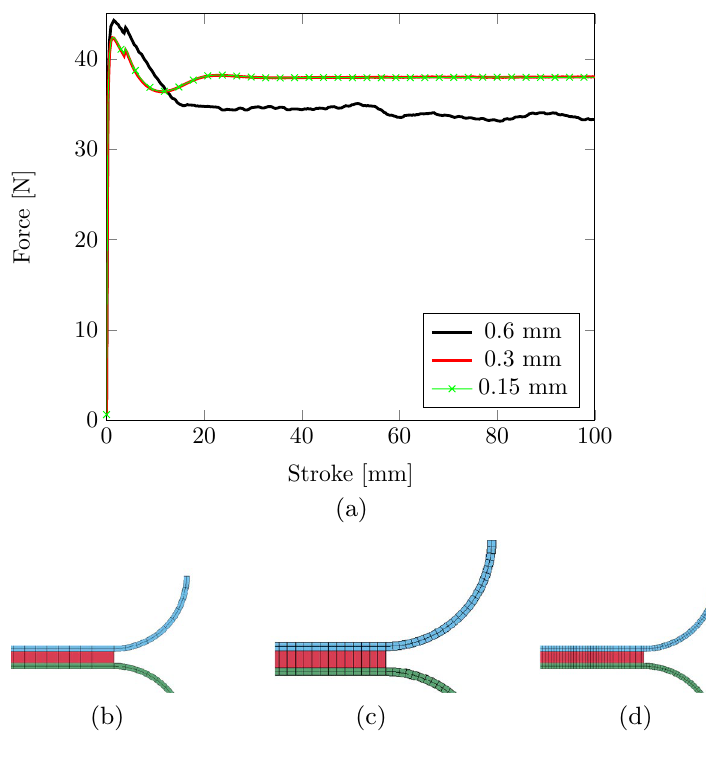
Fig. 14 a Contains the force– displacement responses obtained for models using a single layer of finite elements in the thickness direction of the core. Three mesh densities were studied for the skins, see b – d . From a it is clear that the force–displacement response converges for the mesh density presented in